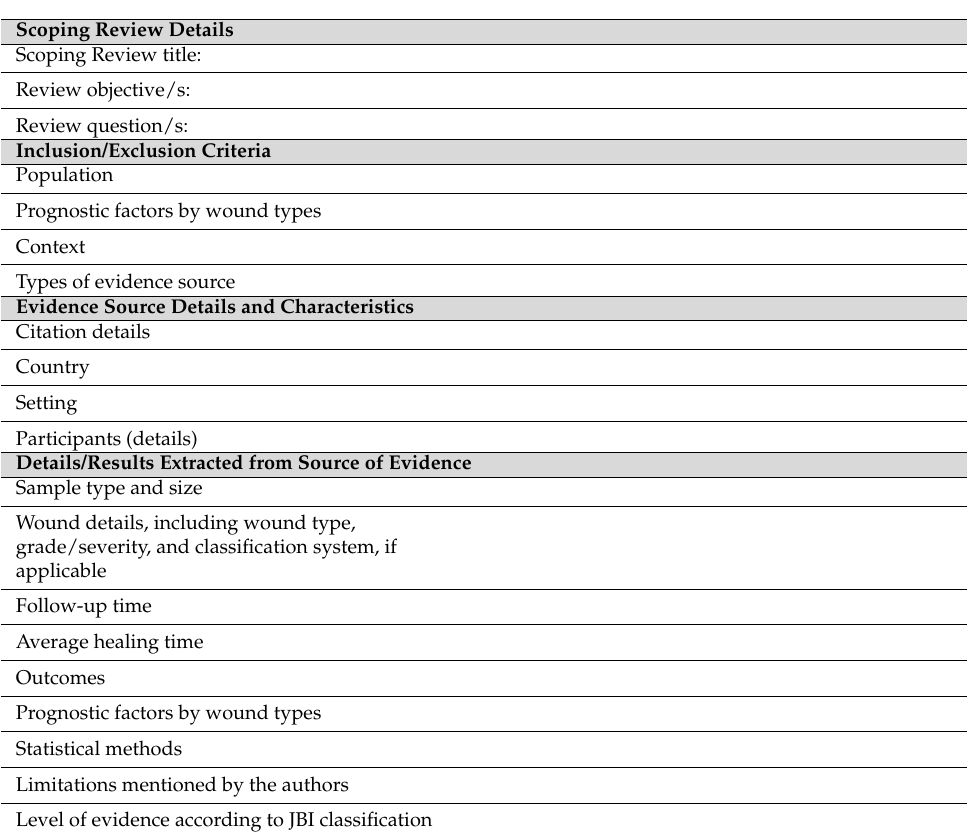
Table A2. Data extraction